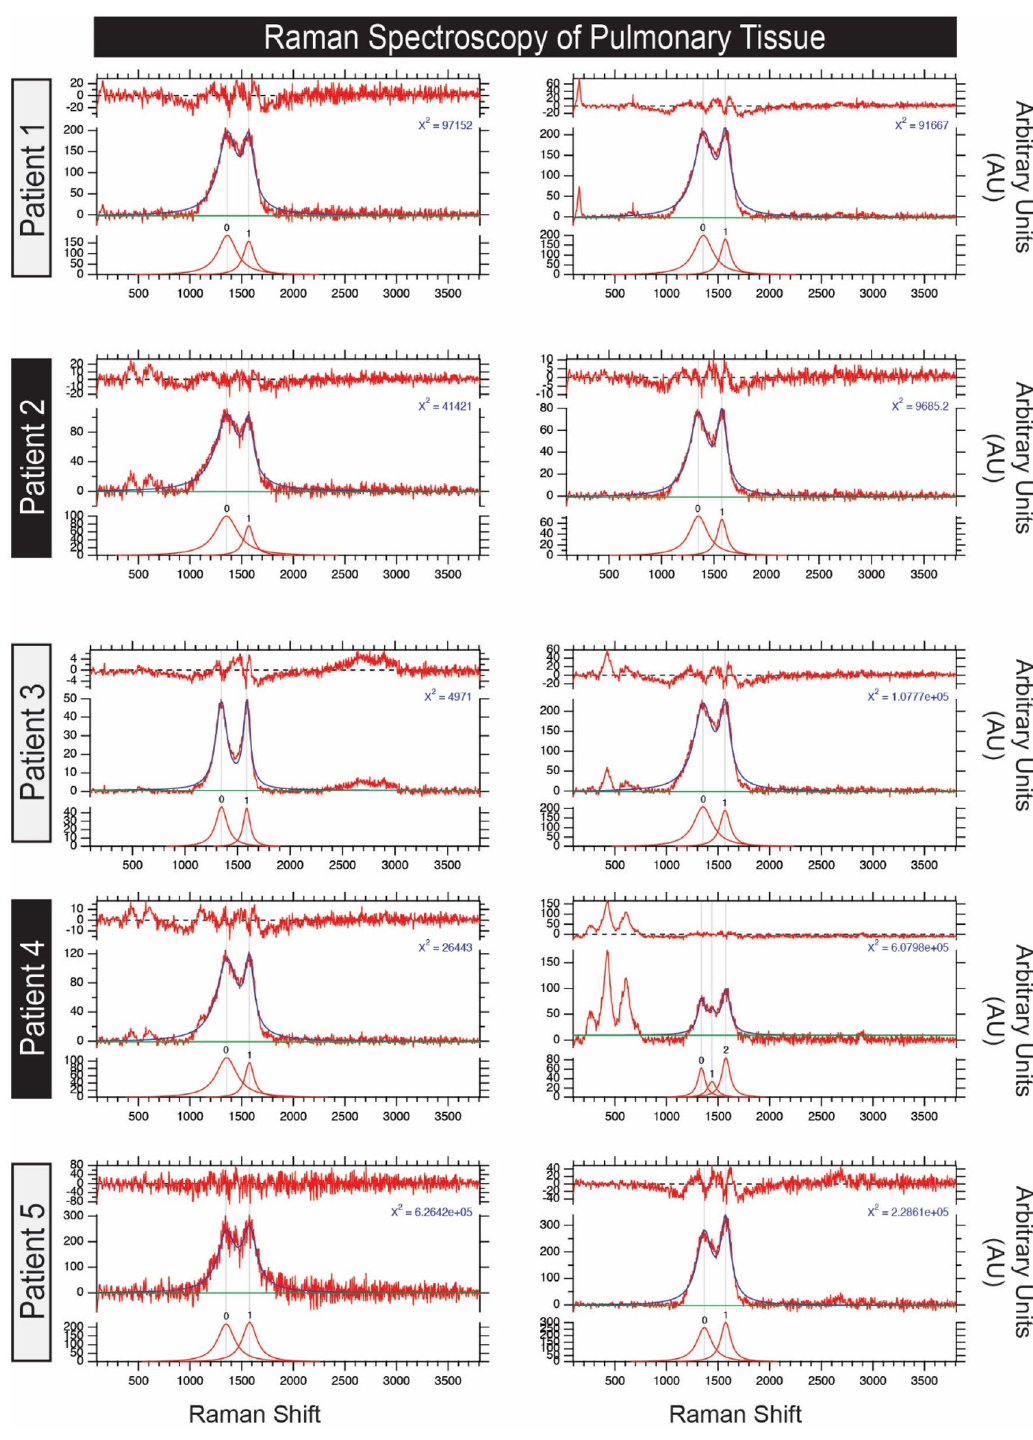
Figure 5. Raman shift plotted against signal intensity for each patient. Tissue from five cohort patients display Raman spectra consistent with polycyclic aromatic hydrocarbons (PAH). Two readings of carbonaceous debris per patient are shown. The carbon D band (~ 1350 cm −1 ) is utilized to estimate the peak combustion temperatures according to the models of Busemann et al. 33 and Cody et al. 34 . Each plot shows the spectrum and modeled fit (center), the Lorentzian curves used to model the carbon D and G bands (bottom), and the model residual